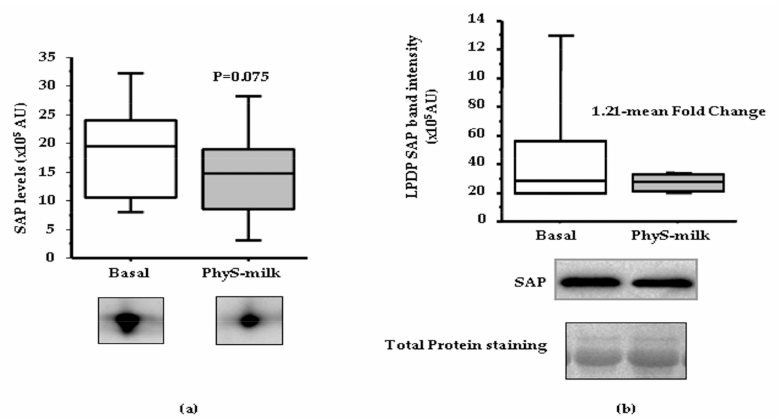
Figure 5. Serum amyloid P (SAP) proteomic profile. ( a ) Box-Plot diagram and 2-DE representative image showing a SAP decreasing trend in the soluble protein fraction of plasma (LPDP) proteomic profile after the intake of PhyS-milk ( p = 0.075); ( b ) Box-Plot and representative western blot image showing changes in SAP in the LPDP samples after PhyS-milk intake ( N = 5; 1.21-Fold change; p =